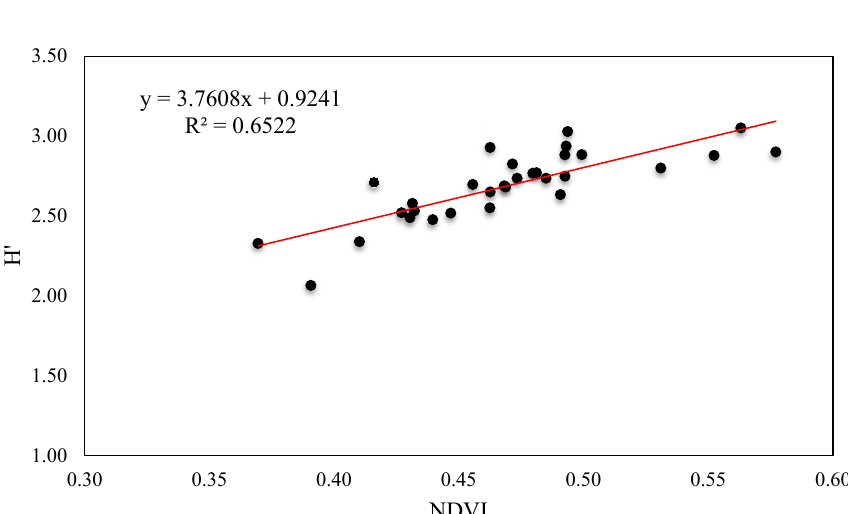
Figure 8. Relationship between normalized difference vegetation index (NDVI) and Shannon–Wiener diversity index (H’) for vegetation in Ghodaghodi Lake Complex, Nepal.